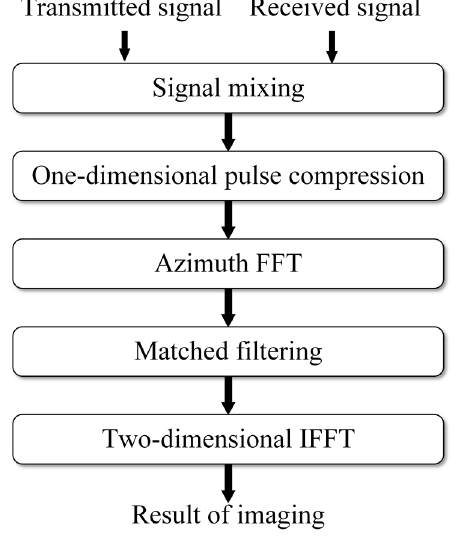
Figure 2. Imaging flow of the radar.